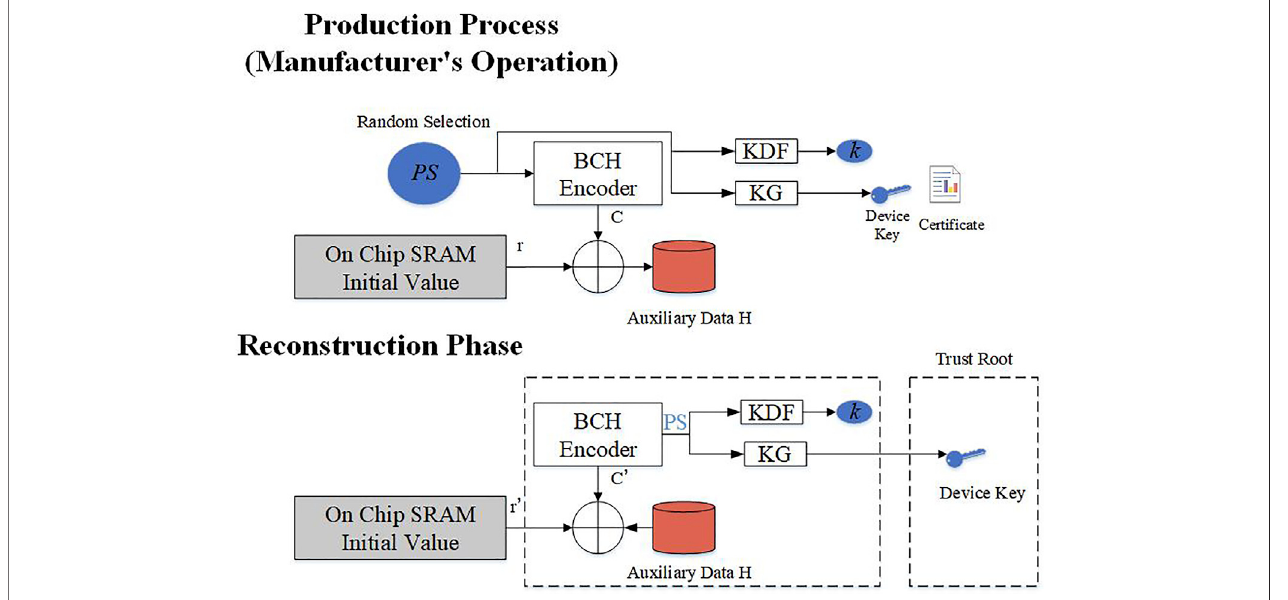
FIGURE 3 | Speci fi c process of production and